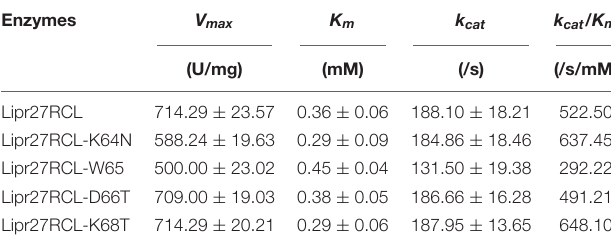
FIGURE 4 | The thermostability of Lipr27RCL, Lipr27RCL-K64N, Lipr27RCL-W65, Lipr27RCL-D66T, and Lipr27RCL-K68T at 50 ◦ C (A) and 60 ◦ C (B) .